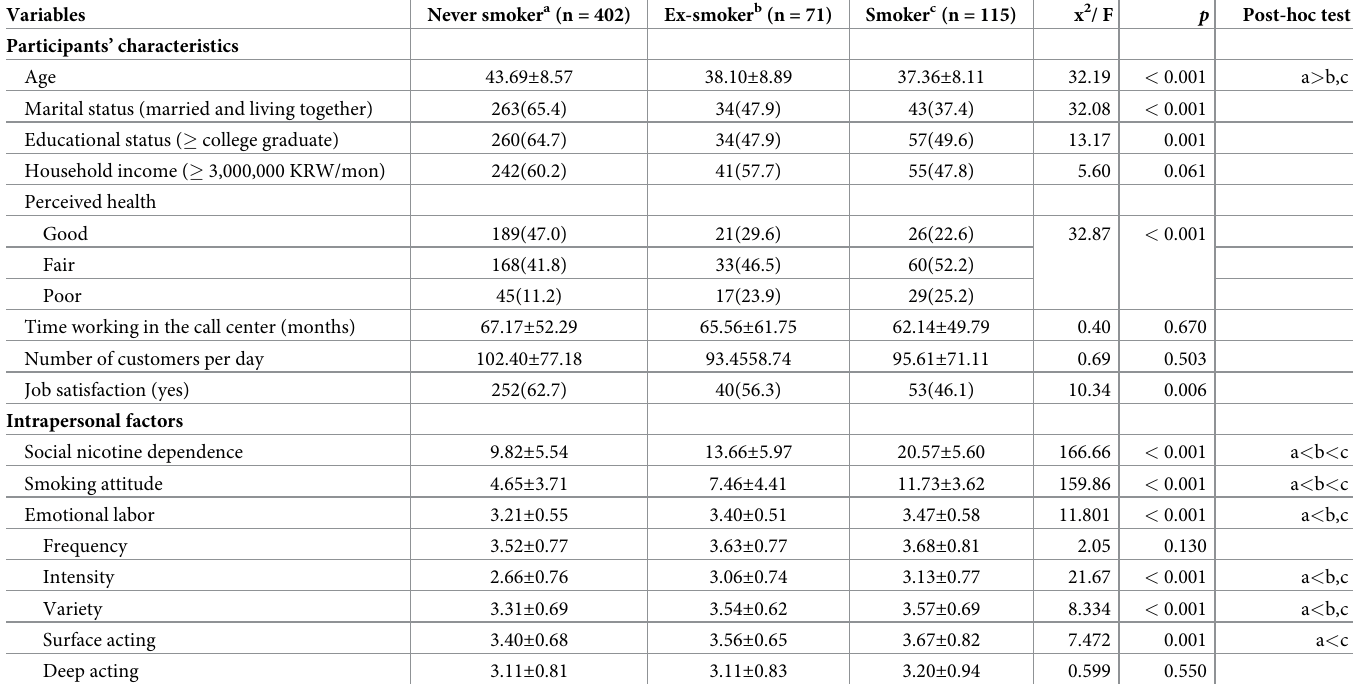
Table 2. Differences in participants’ characteristics and intrapersonal factors by smoking status (N =